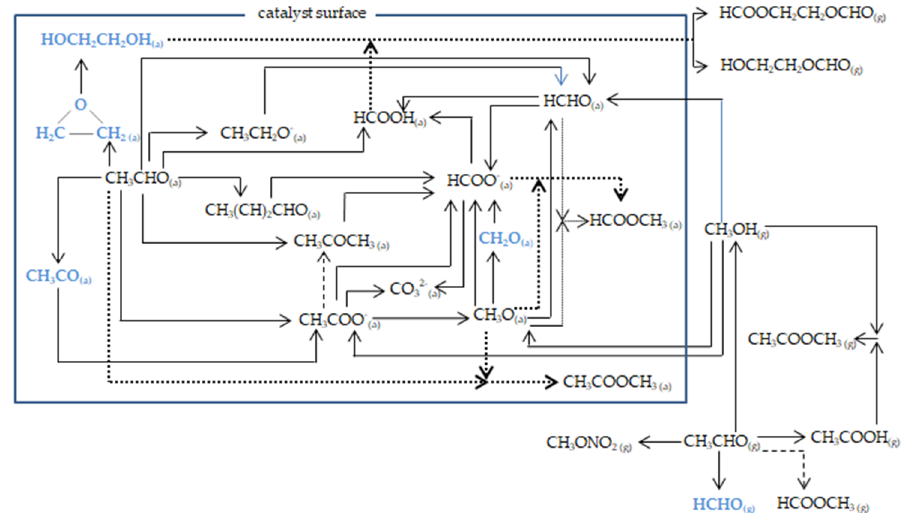
Figure 4. Schematic diagram of the proposed reaction pathway of the PDC degradation of acetaldehyde on Ag/TiO 2 /SiO 2 . The line patterns (solid line, dotted line, dashed line) represent, respectively, either direct routes or routes involving reactions with simple radicals/atoms/sites on the surface (H/OH/O/V O /S), routes involving two surface species and routes leading to the formation of by-products observed only at high energy. Blue color compounds: not detected/identified.